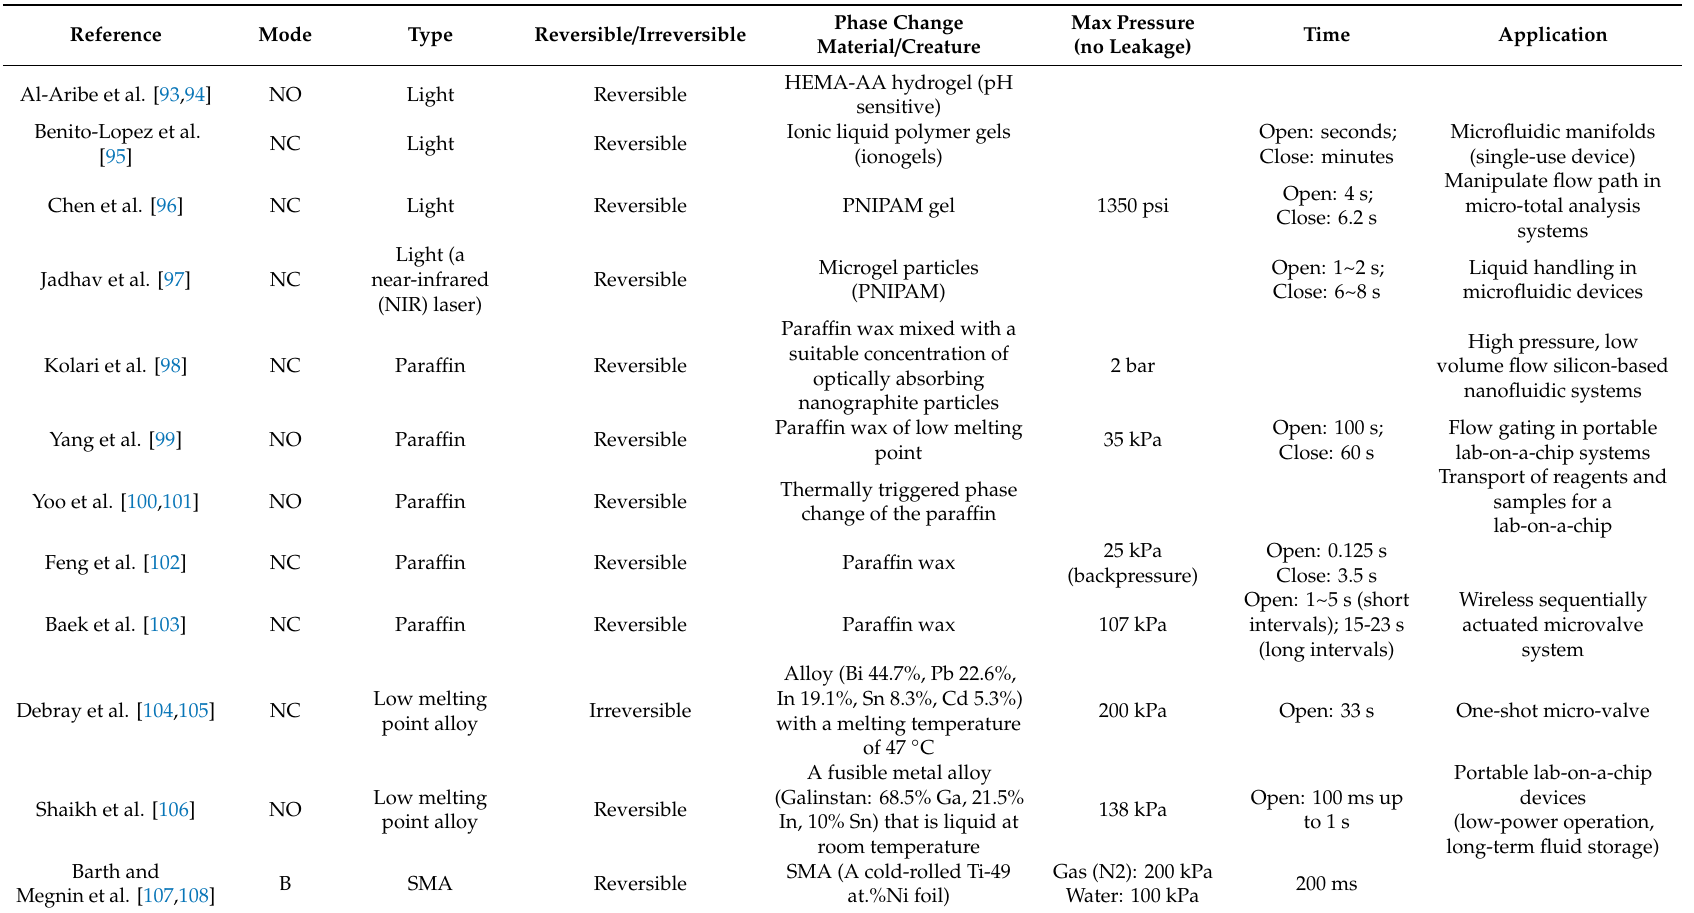
Table 6. Microvalves based on material and biology properties. NC, normally closed microvalve; NO, normally open microvalve; B, bistable; SMA, shape memory